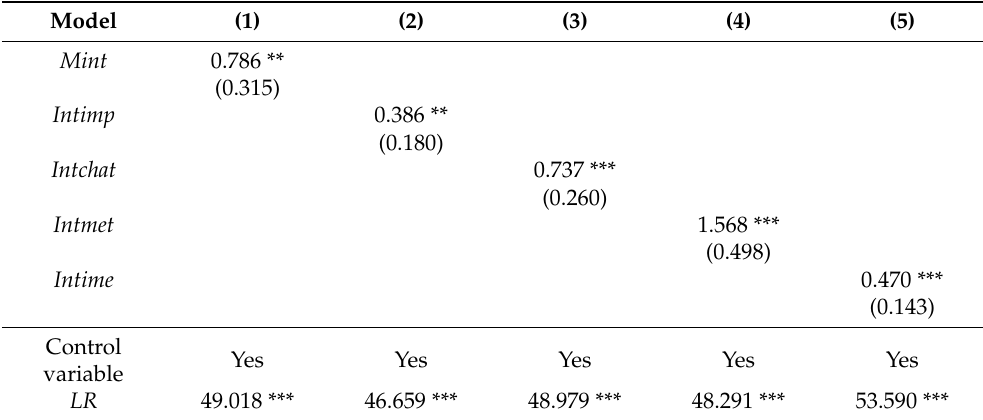
Table 5. Estimated results for Internet usage on divorce risk ( N = 3047).